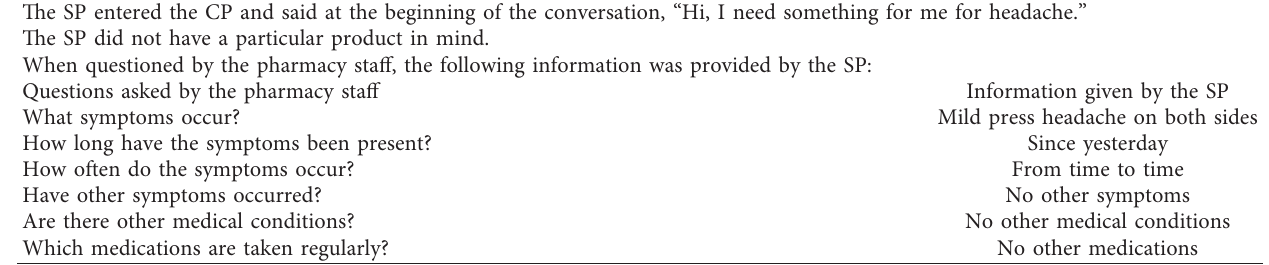
Table 1: Self-purchase scenario [27].